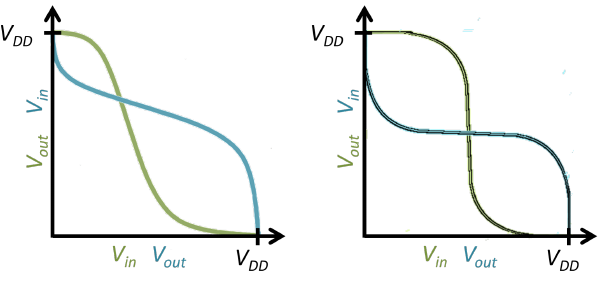
Figure 14: Voltage transfer characteristic for a pseudo-CMOS inverter (on the left) and a CMOS inverter (on the